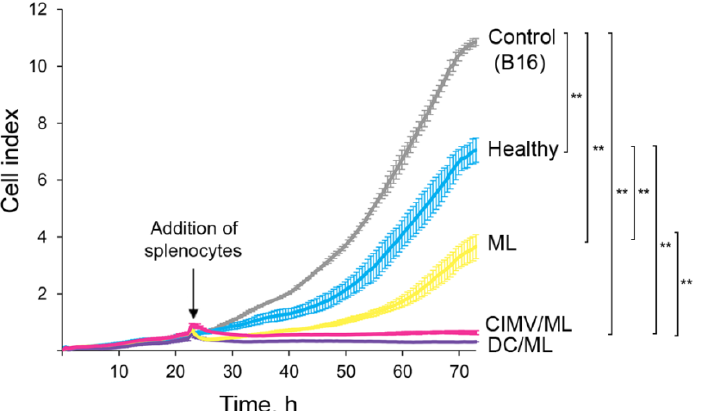
Figure 2. B16-specific cytotoxicity of splenocytes induced in vivo by the vaccines under the study. Control—B16 cells incubated in the absence of splenocytes (gray line). Healthy—B16 cells incubated with splenocytes from healthy mice (blue line). ML, CIMV/ML, and DC/ML corresponded to B16 cells incubated with splenocytes isolated from mice vaccinated with ML, CIMV/ML, or DC/ML vaccines, respectively (yellow, magenta, and indigo lines, respectively). The viability of B16 cells was assessed in real-time mode using xCELLigence (ACEA Biosciences, San Diego, CA, USA). Data presented as mean ± SD. Data were statistically analyzed using one-way ANOVA with post hoc Tukey test; p -value indicates a statistically reliable difference:** p < 0.01.